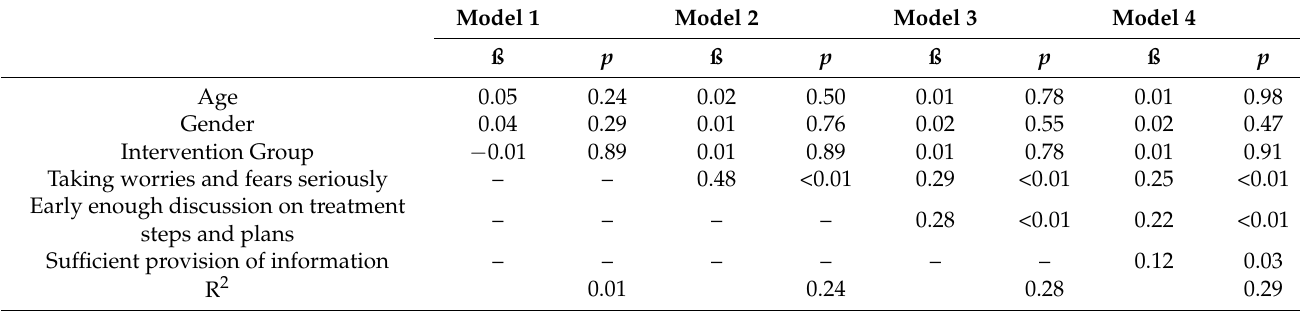
Table 3. Stepwise hierarchical regression results: predicting satisfaction with rehabilitation post-rehabilitation by perceived effectiveness of communication in n = 641 rehabilitation